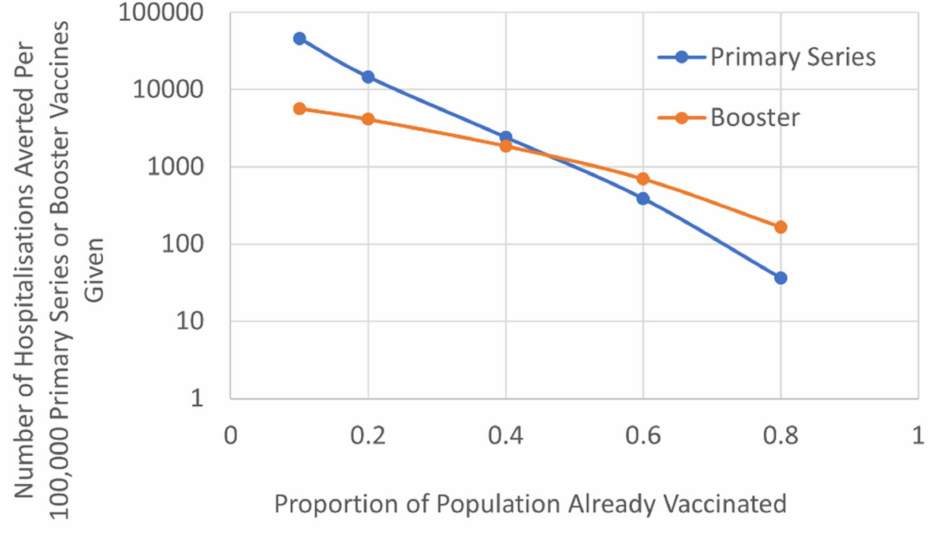
Figure 3. The number of COVID-19 hospitalisations prevented per 100,000 primary series or booster vaccines (logarithmic